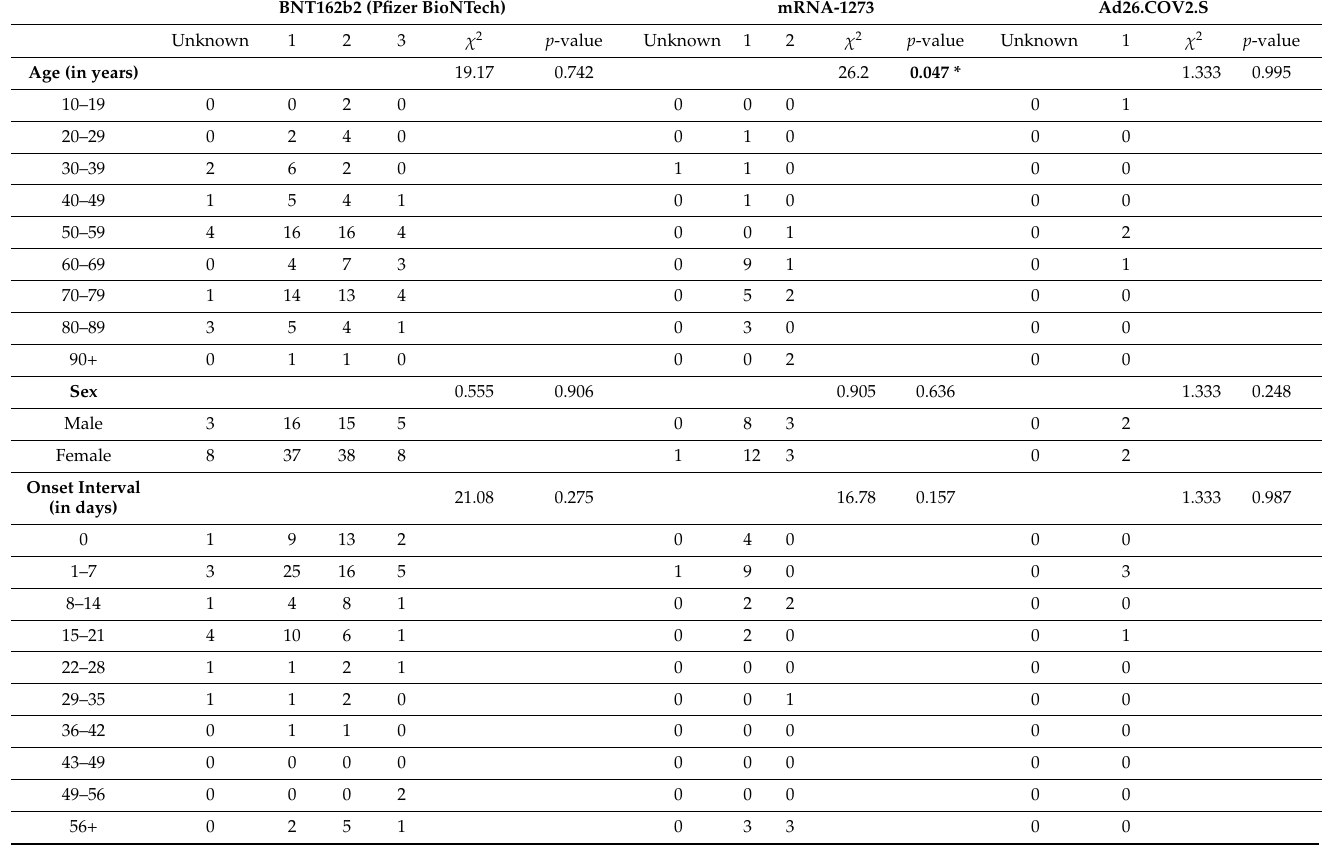
Figure 3. Cumulative-incidence analysis for glaucoma cases reported after administration of BNT162b2 and mRNA-1273 vaccines. Table 5. Association analysis of age, sex, and onset interval with glaucoma following SARS-CoV-2